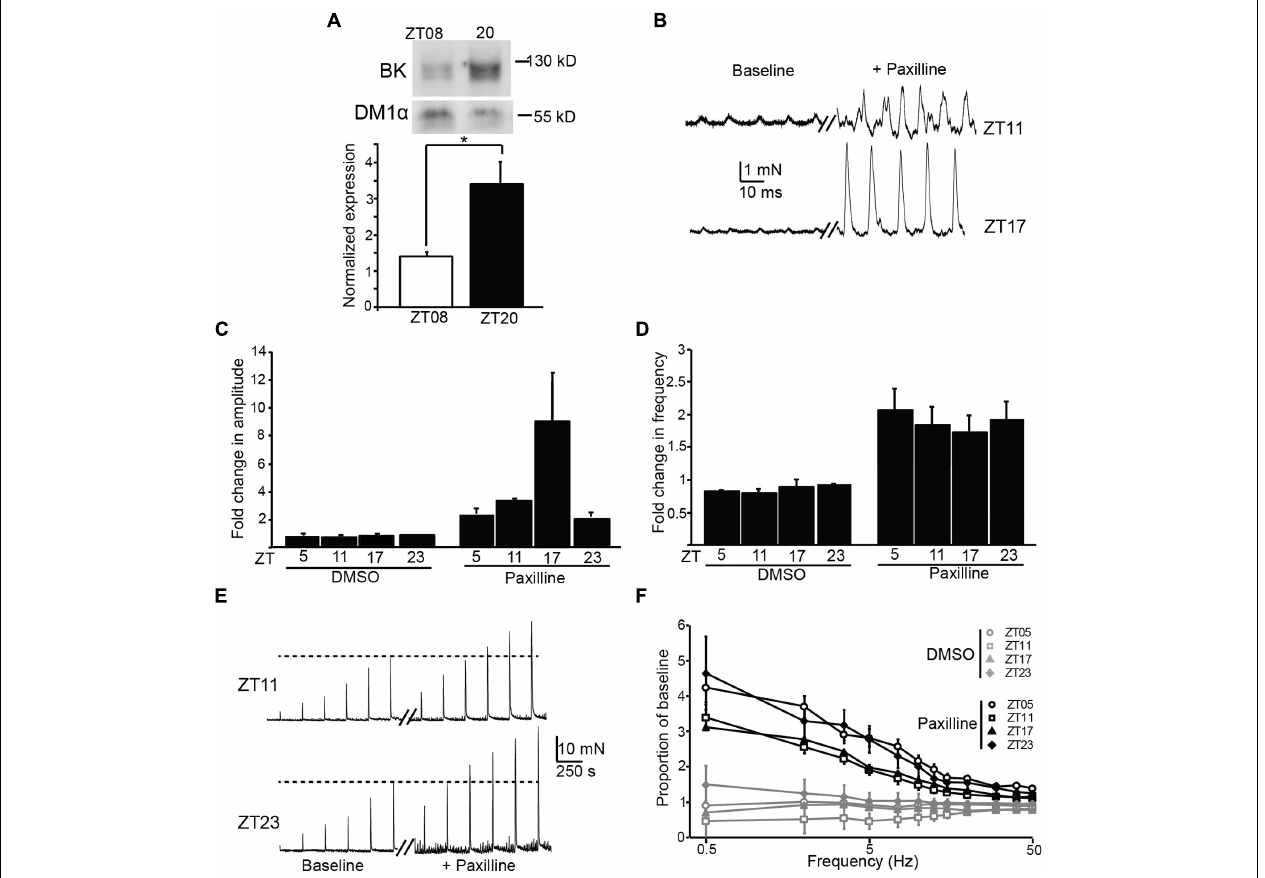
amplitude (factorial ANOVA, p = 10 − 4 and 0.01, respectively), but only the effect of PAX was significant on phasic frequency ( p = 10 − 8 ). n = 3–6 mice (6–12 UBSM strips) per timepoint and condition. DMSO had no effect on either parameter. (E) Representative EFS-evoked contractile activity at ZT11 and ZT23, at baseline and after PAX application. (F) Increase in EFS-evoked amplitude after PAX or DMSO (control) as a proportion of baseline. The effect of PAX was significant (factorial ANOVA, p = 10 − 5 ), but the effect of time was not ( p = 0.99). n = 5–6 mice (10–12 UBSM strips) per timepoint and condition. All data are mean ±